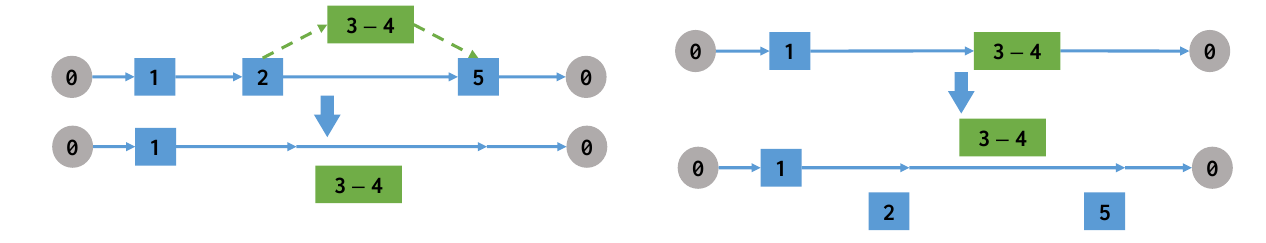
Figure 6. Change the assignment the task.